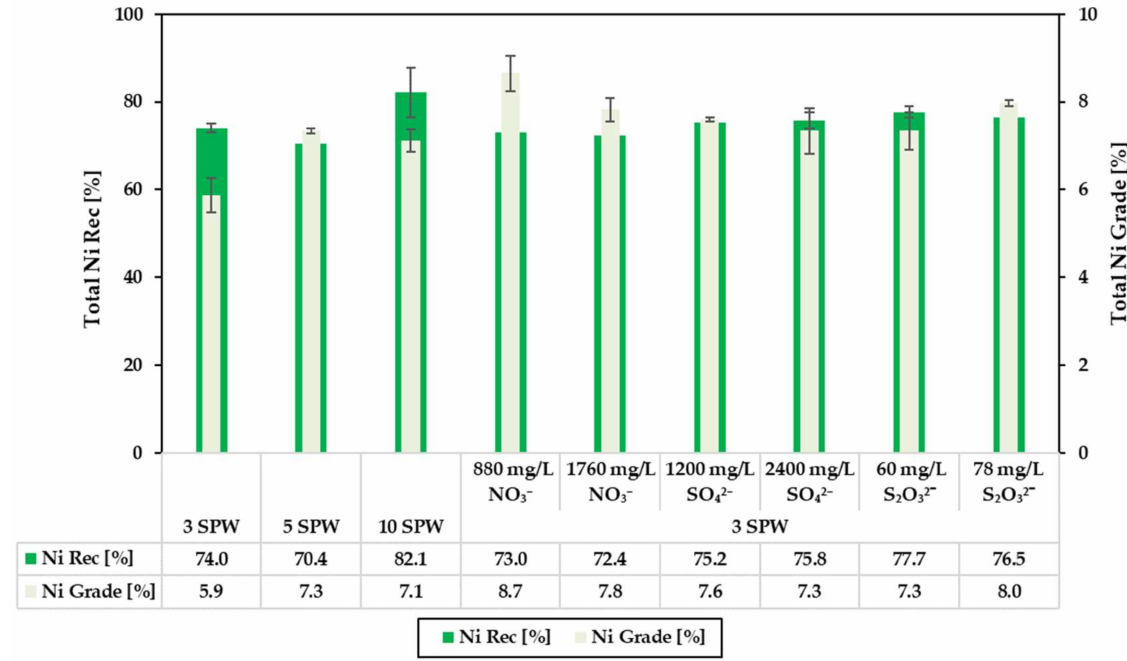
Figure 4. Nickel Rec and grade at different anion concentrations, where ‘Rec’ refers to